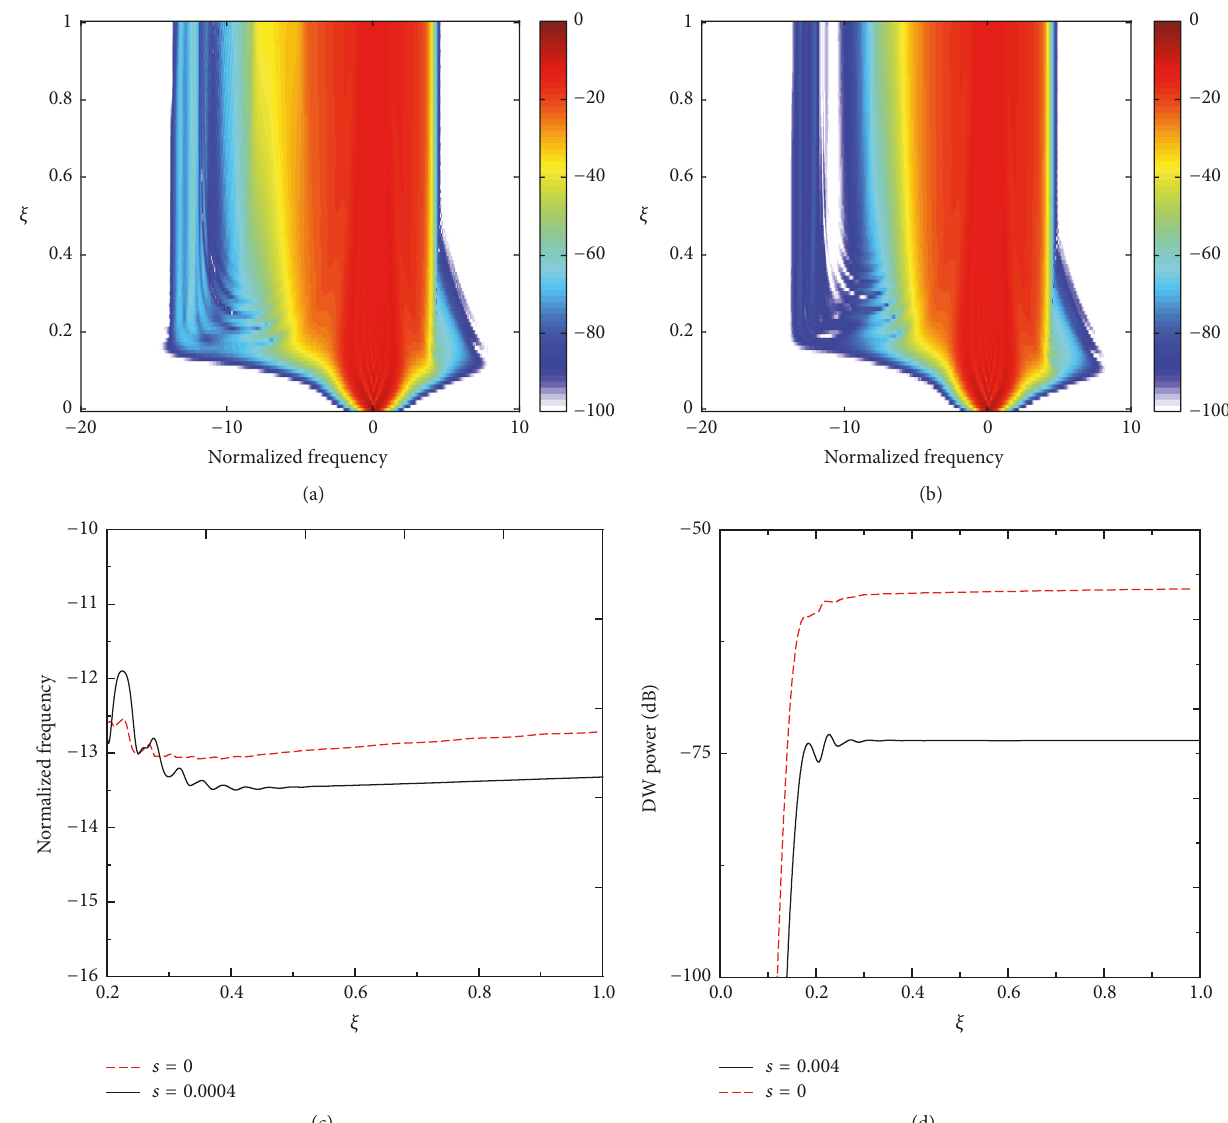
Figure 1: Simulate spectrum of a hyperbolic secant pulse propagating in the normal dispersion regime at the different SS coefficients, (a) 𝑠 = 0 , (b) 𝑠 = 0.004 , where 𝛿 = 0.0267 , 𝑁 2 = 200 . Central frequency (c) and relative average intensity (d) of the red-shift DW as a function 3 of normalized propagation distance, where 𝑠 = 0 (red dashed curve) and 𝑠 = 0.004 (dark solid